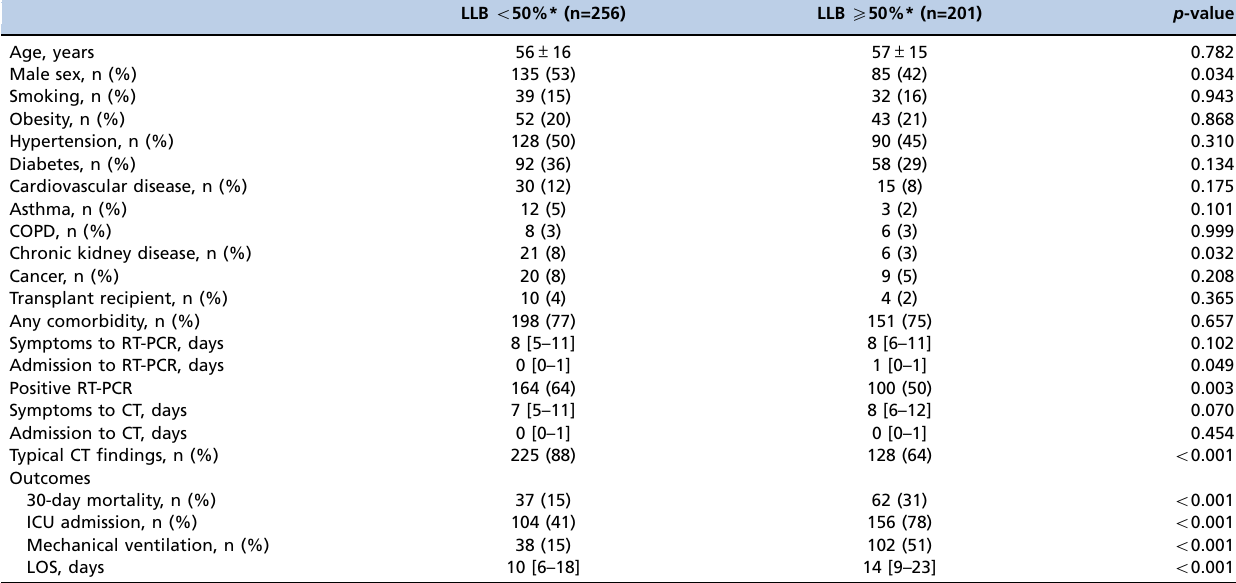
Table 3 - Baseline and outcomes characteristics of admitted patients, stratified by LLB